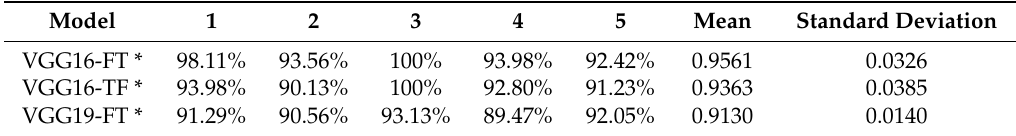
Table 11. Overall classification accuracies on the dataset for various network configurations using 5-fold cross